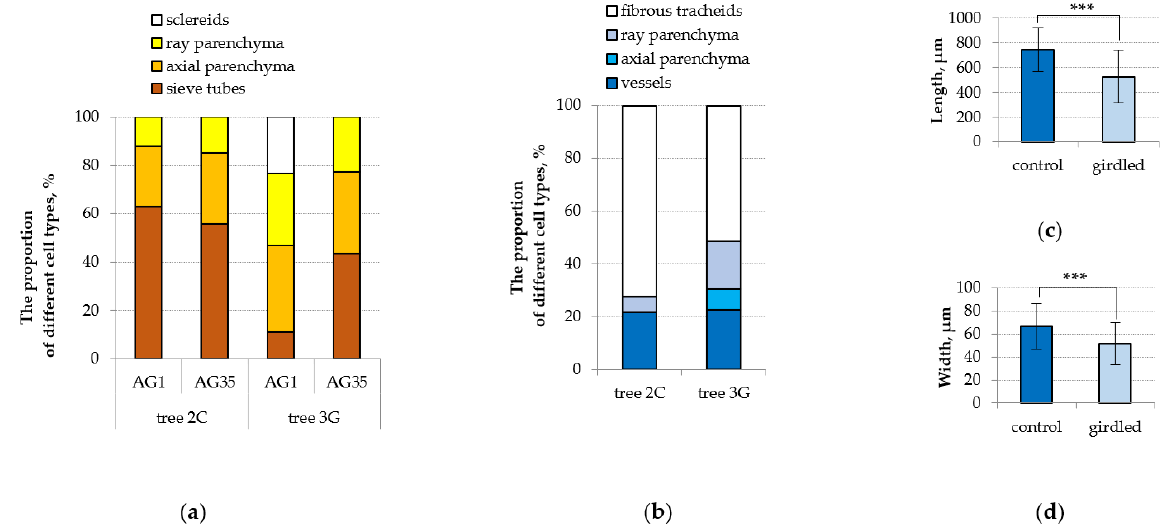
Figure 5. Anatomical characteristics of conducting tissues: ( a ) the proportion of different cell types in late phloem; ( b ) the proportion of different cell types in xylem in AG35 level; ( c ) length of vessel elements in AG35 level; ( d ) width of vessel elements in AG35 level. For ( a , b ), representative values are given for one control (tree 2C) and one girdled tree (tree 3G). Characteristics of all trees are provided in the Supplementary Materials, Figure S2. The data in the diagrams are presented as M ± SD. Asterisks mark significant differences between groups (*** p < 0.001), n.s.—no differences.